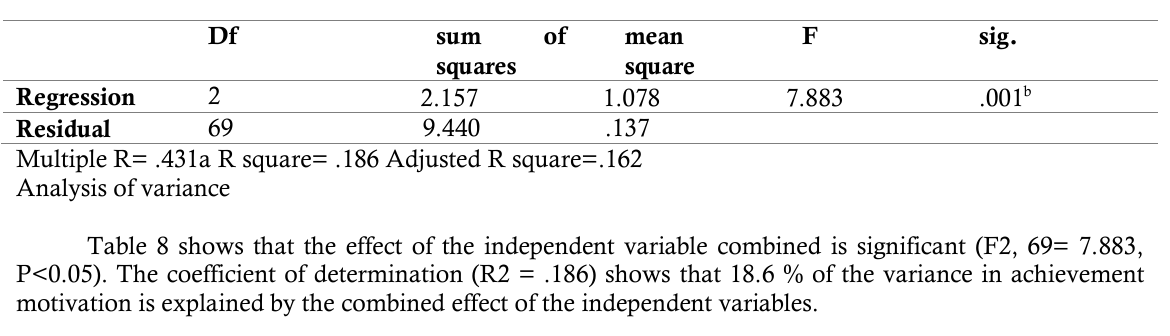
Table 9 . Regressions Weight of the Independent Variables